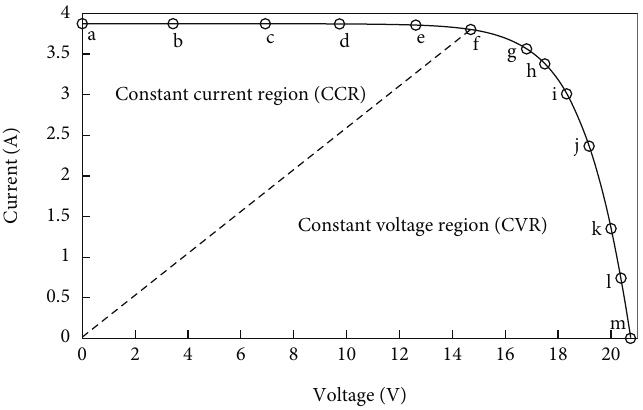
Figure 4: CCR/CVR recognition in the I - V curve: dotted lines separate the two